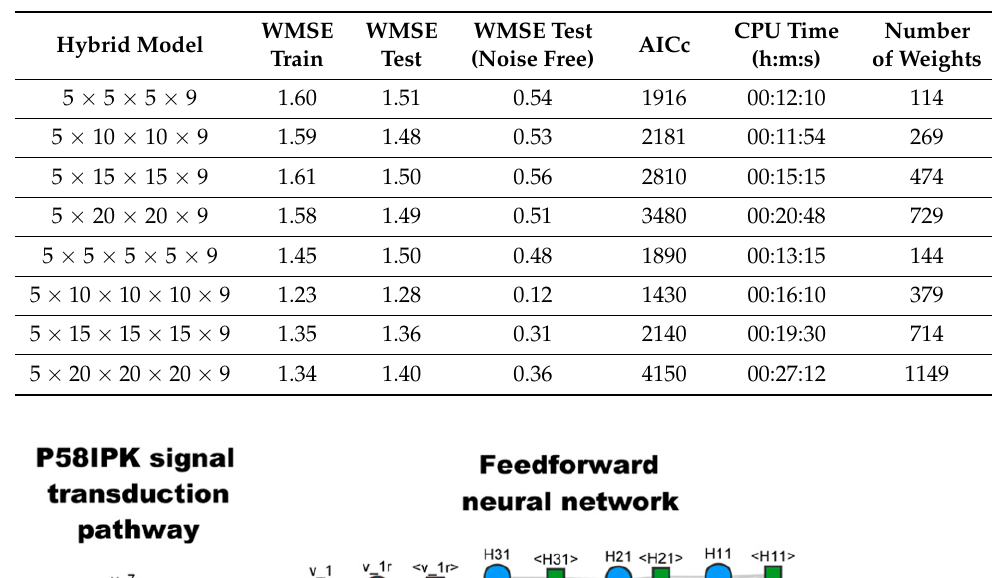
Table 3. Training metrics of different hybrid models for the P58IPK signal transduction pathway case study (goodman). The dataset was divided into four experiments for training (400 training examples for each state variable) and five for testing (500 testing examples for each state variable). The training was performed with ADAM with default hyperparameters as suggested by Kingma (2014) ( α = 0.001, = 0.9, = 0.999 and ζ = 1 × 10 − 8 ). The number of iterations was 5000. The minibatch size was 78% and weight dropout probability was 0.22 as suggested by Pinto et al. (2022). The AICc was computed on the training set only. The noise-free WSSE measures the error between noise-free data (e.g., true process behavior) and model predictions.